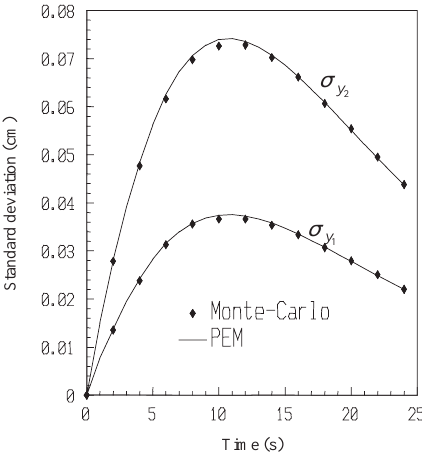
Fig. 4. Displacement standard deviation for non white spectrum and time lag T = 1 . 6